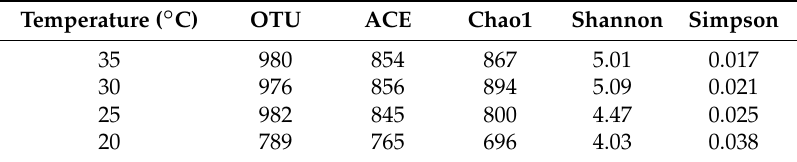
Table 4. Alpha-diversity in the methanogenic phase at different